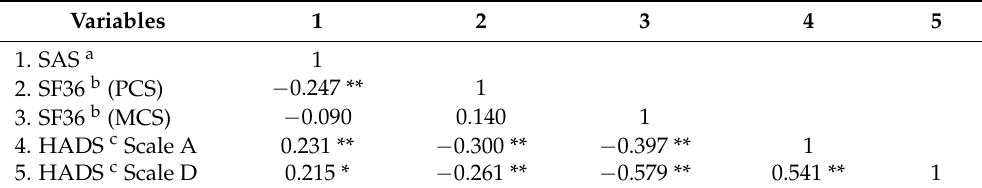
Figure 1. Sexual attitude scale (SAS) for gender. Correlations among the study variables were examined (Table 2). All the variables except SF36 mental health were significantly correlated with each other. SAS positively correlated with anxiety (r.231, p = 0.009) and depression score (r. 0.215, p < 0.01) and negatively with SF36 physical health (r. − 0.247, p = 0.005). SF36 physical health correlated negatively with anxiety (r. − 0.261, p = 0.003) and depression score (r. − 0.300, p < 0.001). Contrary to expectation, SF36 mental health was not correlated with SAS (r. − 0.090, p = 0.314) while it was negatively correlated with anxiety (r. − 0.397, p < 0.001) and depression (r. − 0.579, p < 0.001). Table 2. Pearson correlation between study variables.